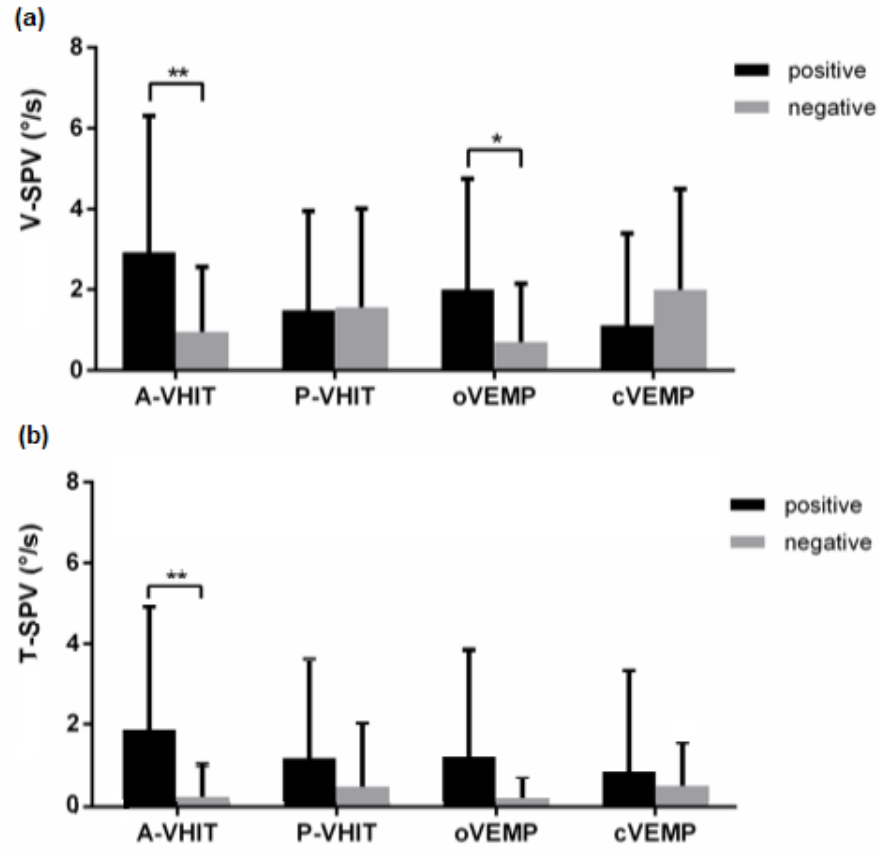
Figure 4. V-SPV ( a ) and T-SPV ( b ) bar charts with standard error comparison between positive and negative results of vestibular tests. (*: p < 0.05, **: p < 0.01). For the SVIN-SPV torsional component (T-SPV): only the A-VHIT positivity was 0.162 and 0.581, respectively) (Figure significantly related to higher values of the T-SPV (odd ratio: 1.82+/ − 0.75, p = 0.017). 0.215, 0.162 and 0.581, respectively) (Figure 4).